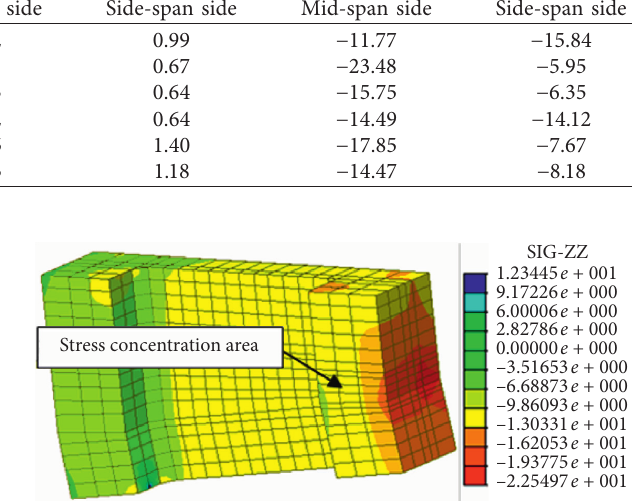
Figure 8: Principal compressive stress of bevel section